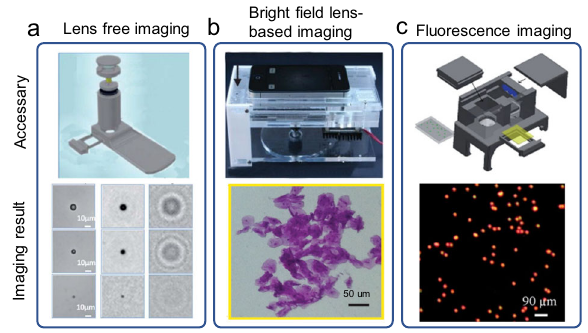
Fig. 3 | Imaging modalities. a Schematic diagram of an optical accessary for lens- free imaging and its imaging result ( fi gure adapted with permission from Tseng etal. 58 ). b PictureofanopticalaccessaryforBright fi eldlens-basedimagingandits imaging result ( fi gure adapted with permission from Switz et al. 62 ). c Schematic diagram of an optical accessary for fl uorescence imaging and its imaging result ( fi gure adapted with permission from Zhu et al. 197